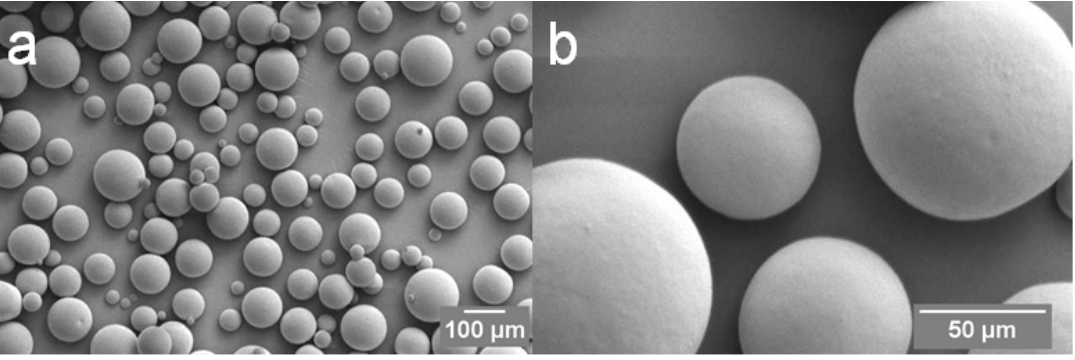
Figure 2. Representative scanning electron microscopy images ( a ) at low magnification and ( b ) at high magnification of PLGA/PLGA-PEG-PLGA composite microparticles showing spherical